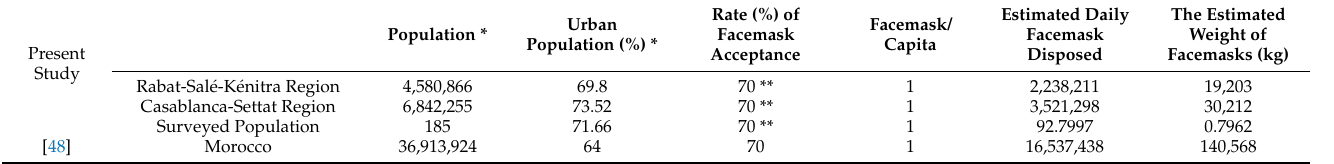
Estimated Daily